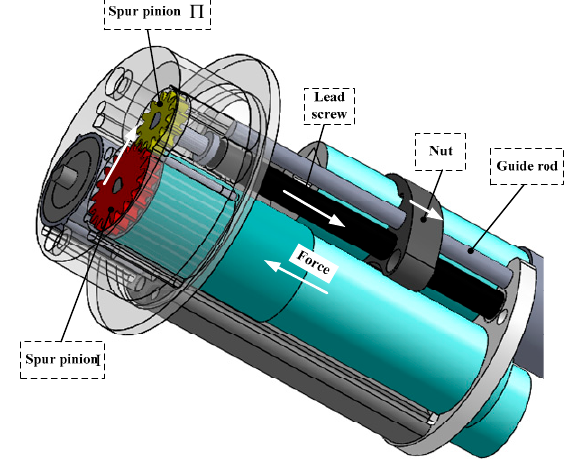
Figure 6. The working principle of the telescoping mechanism.